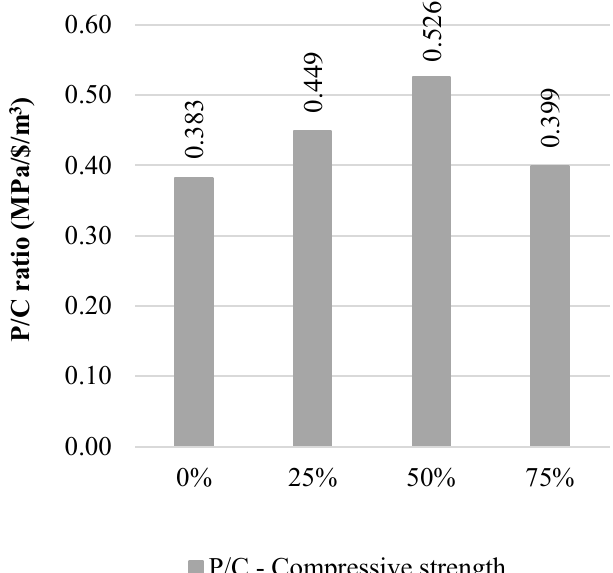
Figure 16. P/C ratios for compressive strength.